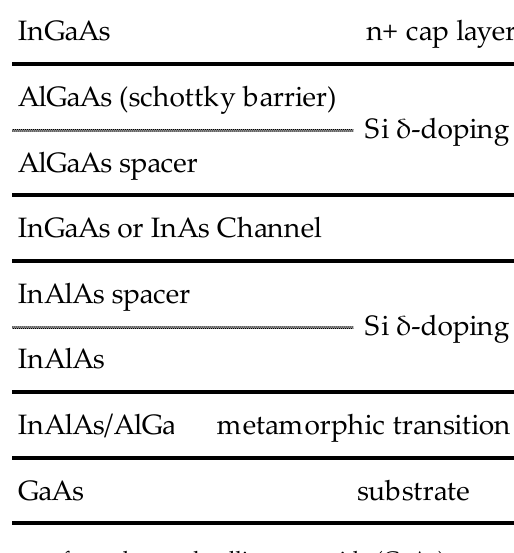
Figure 2. Epitaxial structure of an advanced gallium arsenide (GaAs) metamorphic HEMT (mHEMT).